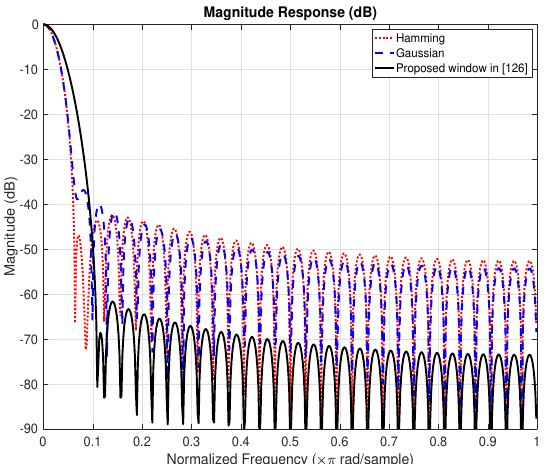
Figure 3. Frequency responses of Hamming window, Gaussian window and the new window proposed in